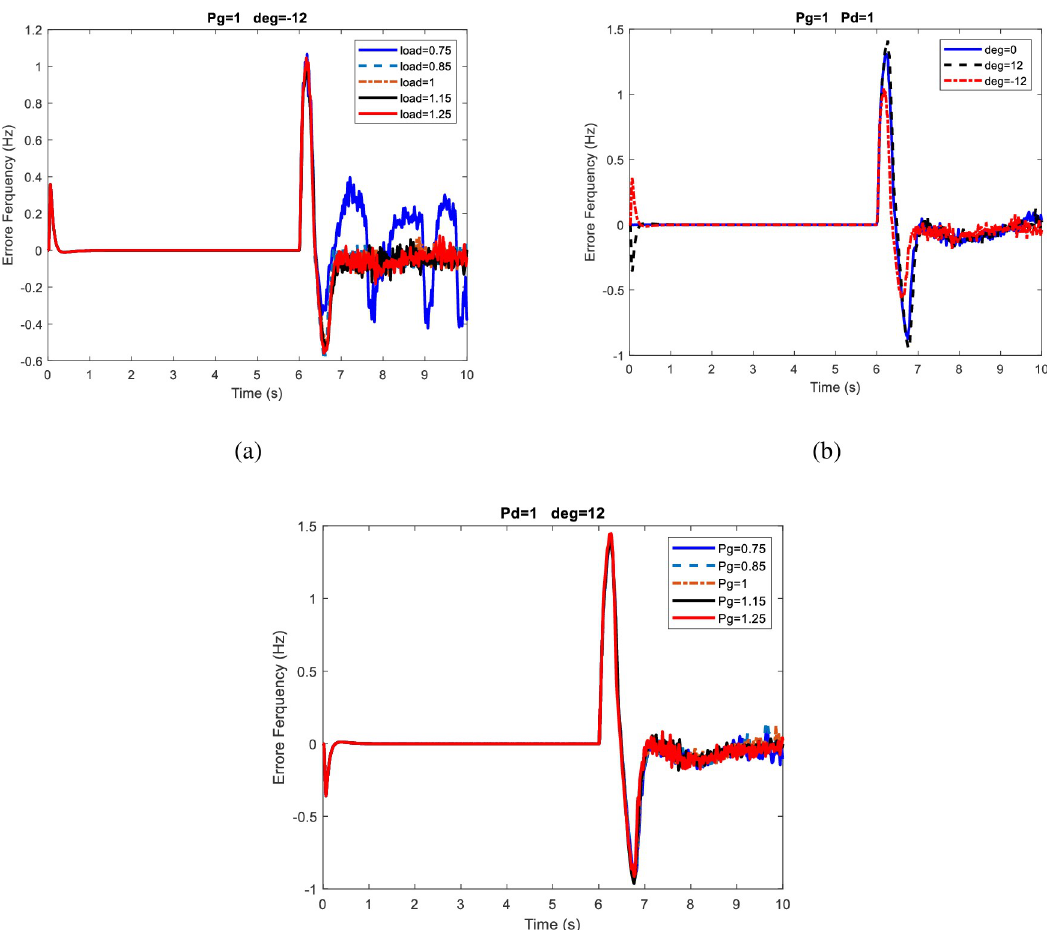
Fig 6. Comparison of frequency deviation in different modes for the first scenario.